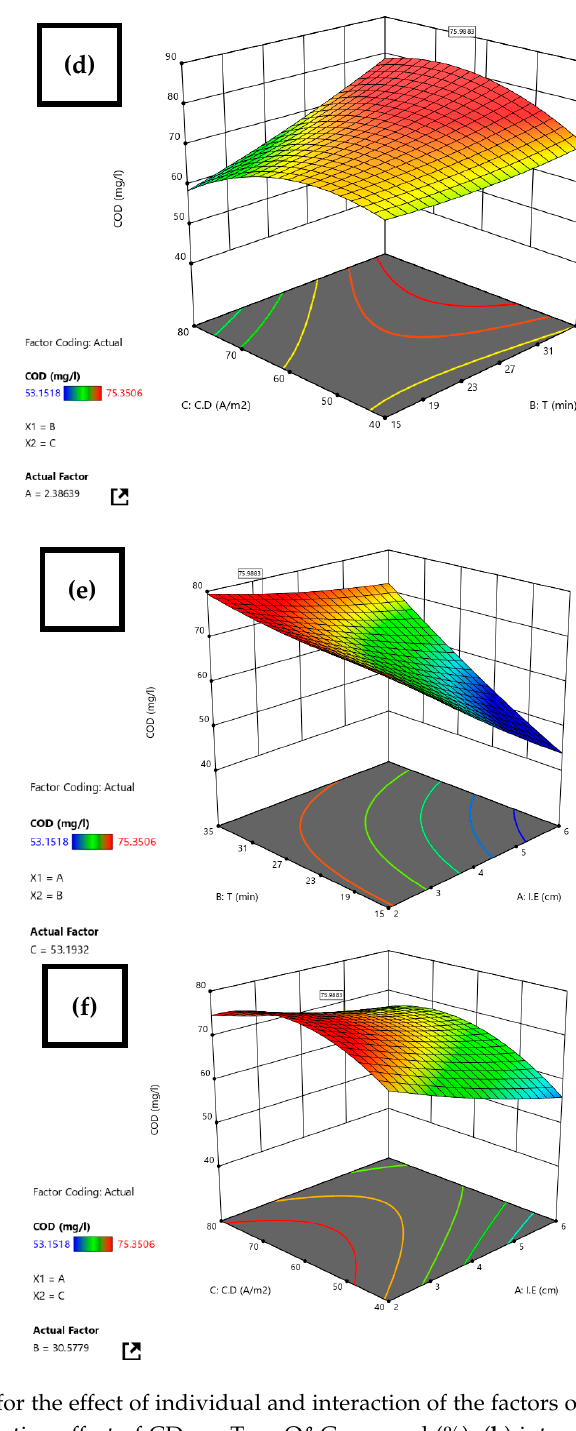
effect of CD vs. ID on O&G removal (%), ( c ) interaction effect of T vs. ID on O&G removal (%), action effect of CD vs. T on COD removal (%), ( e ) interaction effect of T vs. ID on COD removal (%),